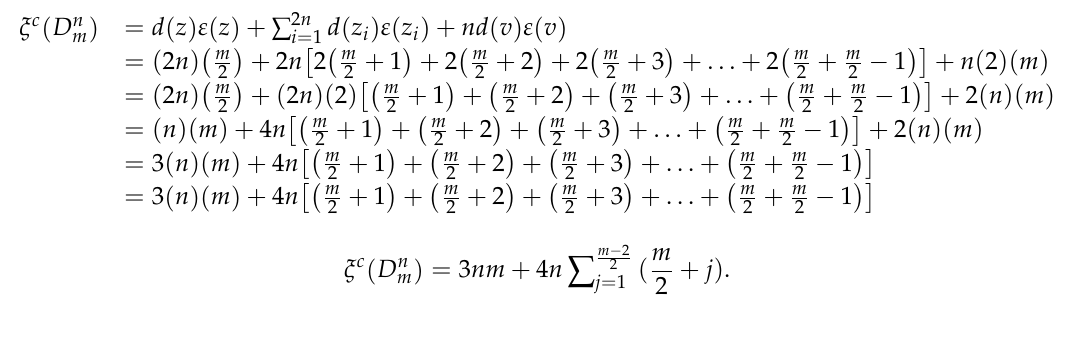
with eccentricity of 6